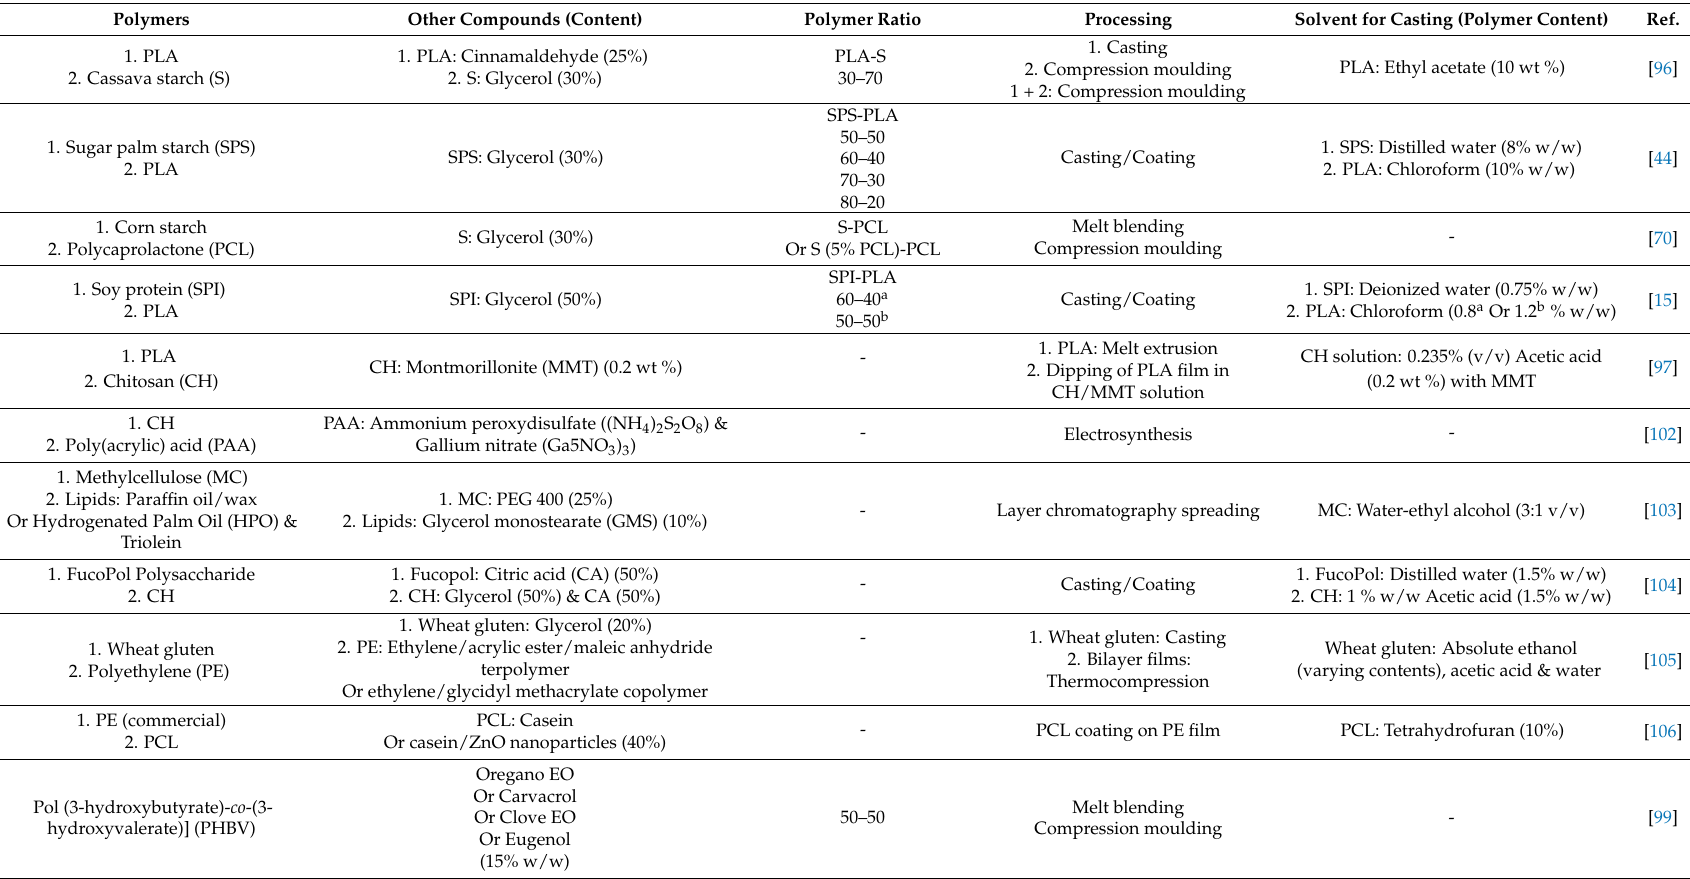
Table 6. Recent studies on polymer bilayer